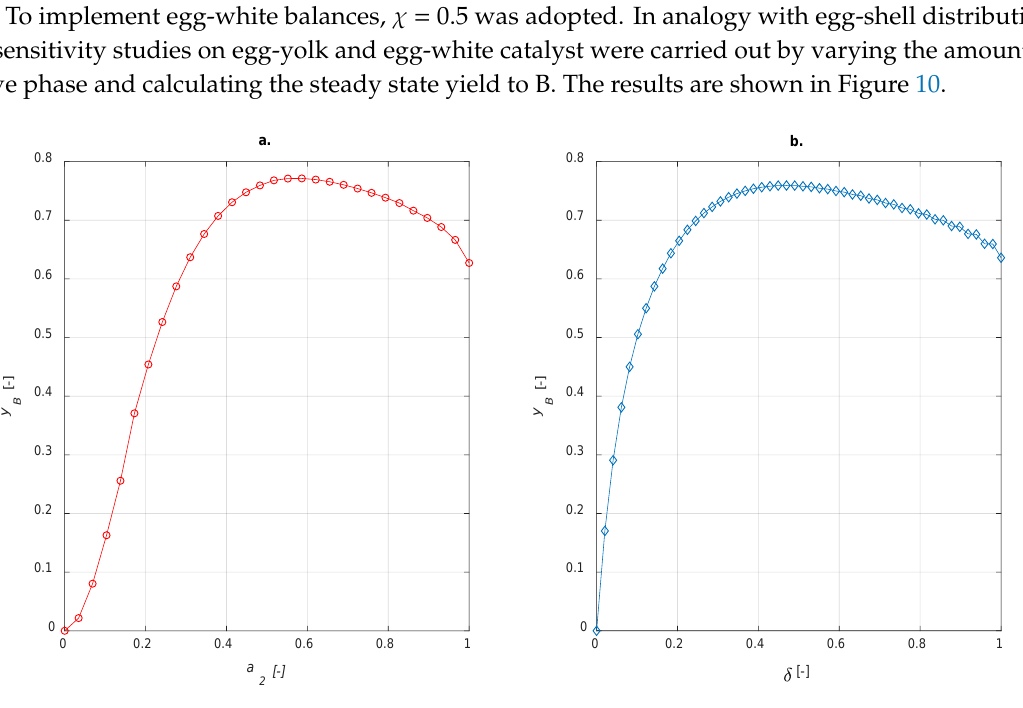
Figure 10. Yield to B vs. active phase thickness for ( a ) egg-yolk catalyst ( b ) egg-white catalyst.